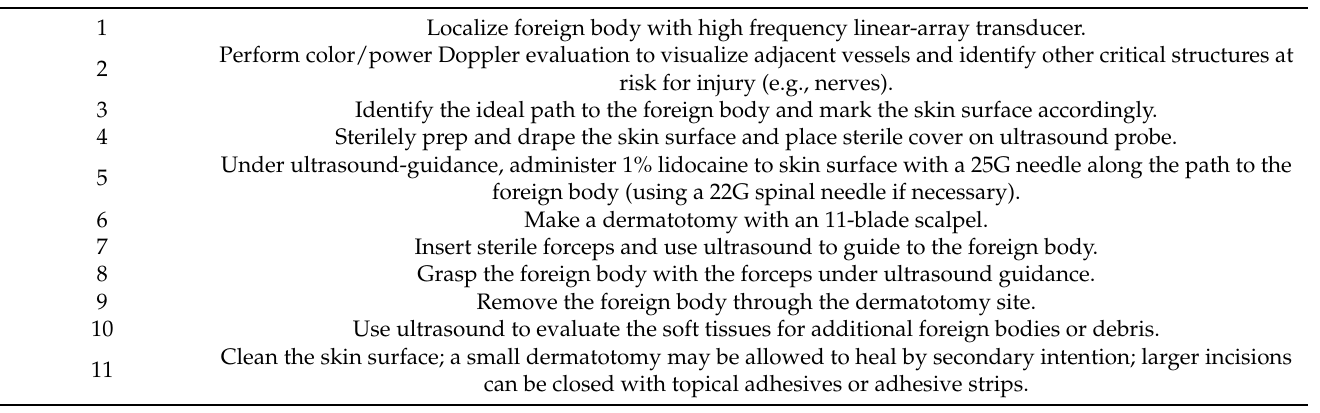
Table 2. Ultrasound-guided foreign body removal step-by-step